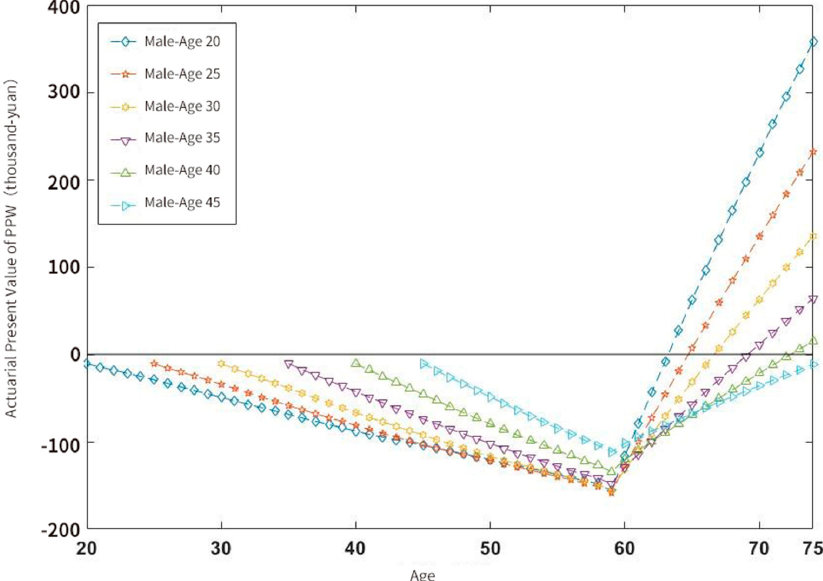
Figure 12. The impact of different initial insured ages on the present value of PPW. (the initial annual salaries of the insured men is 200,000 yuan).